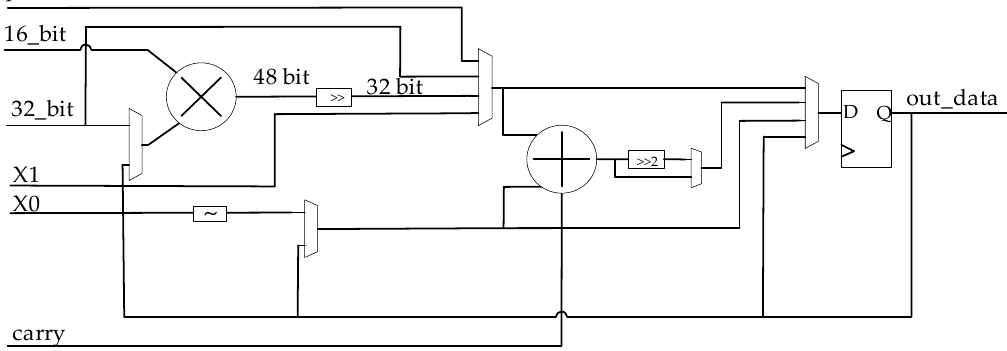
Figure 5. Structure of the processing element (PE).